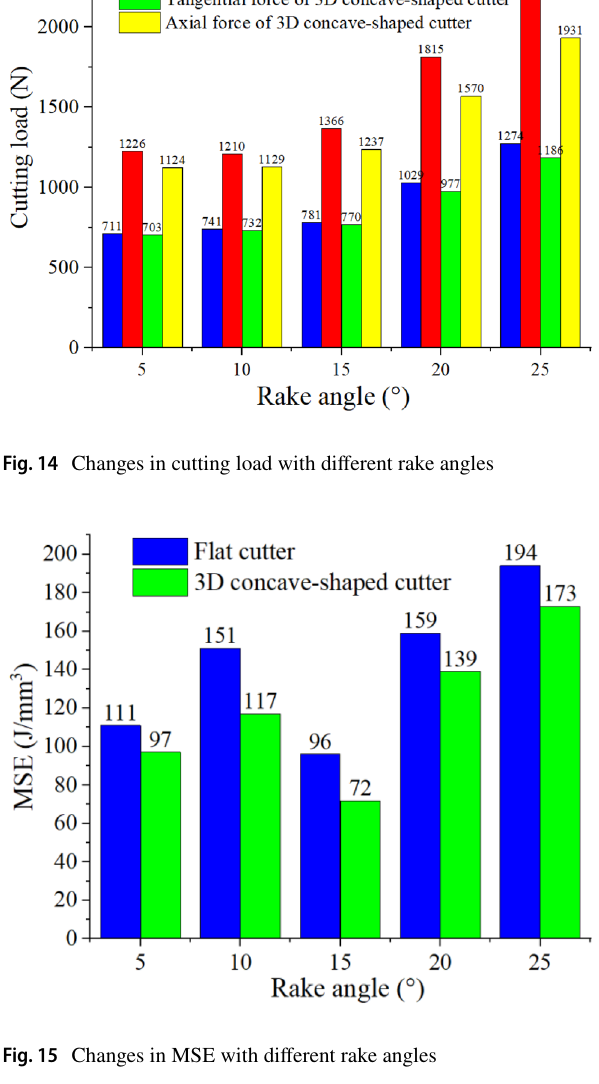
Fig. 15 Changes in MSE with different rake angles